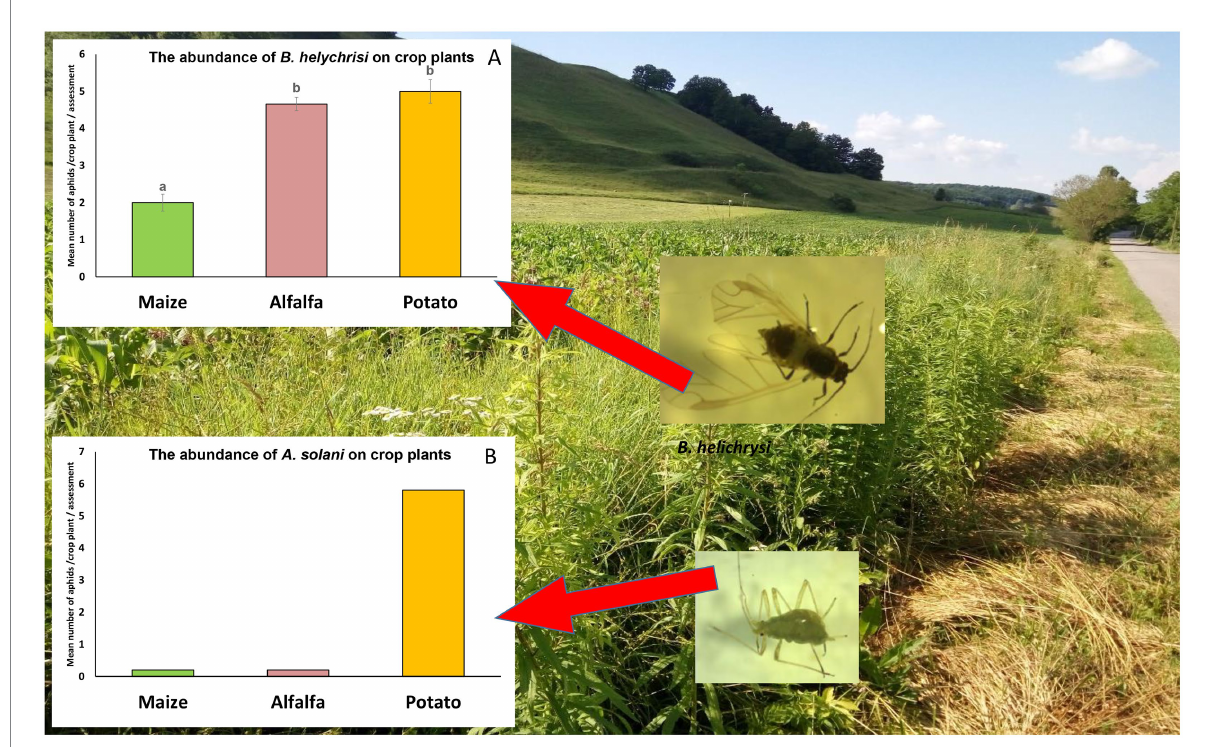
FIGURE 2 Brachycaudus helichrysi (A) and Aulacorthum solani (B) abundance on crop plants. Data for B. helichrysi from goldenrod were compared using Kruskal-Wallis followed by Mann–Whitney U tests. Data from crop plants were compared using ANOVA followed by Tukey testing. Bars represent standard errors. No statistics were done for A. solani because of low abundances.